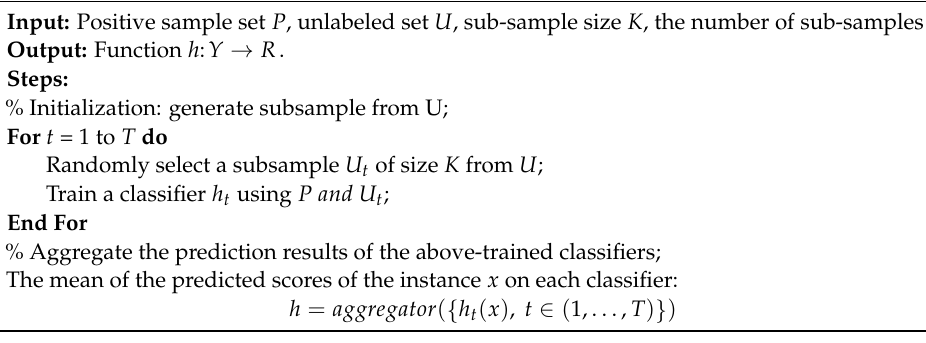
Algorithm 1. Bagging positive-unlabeled